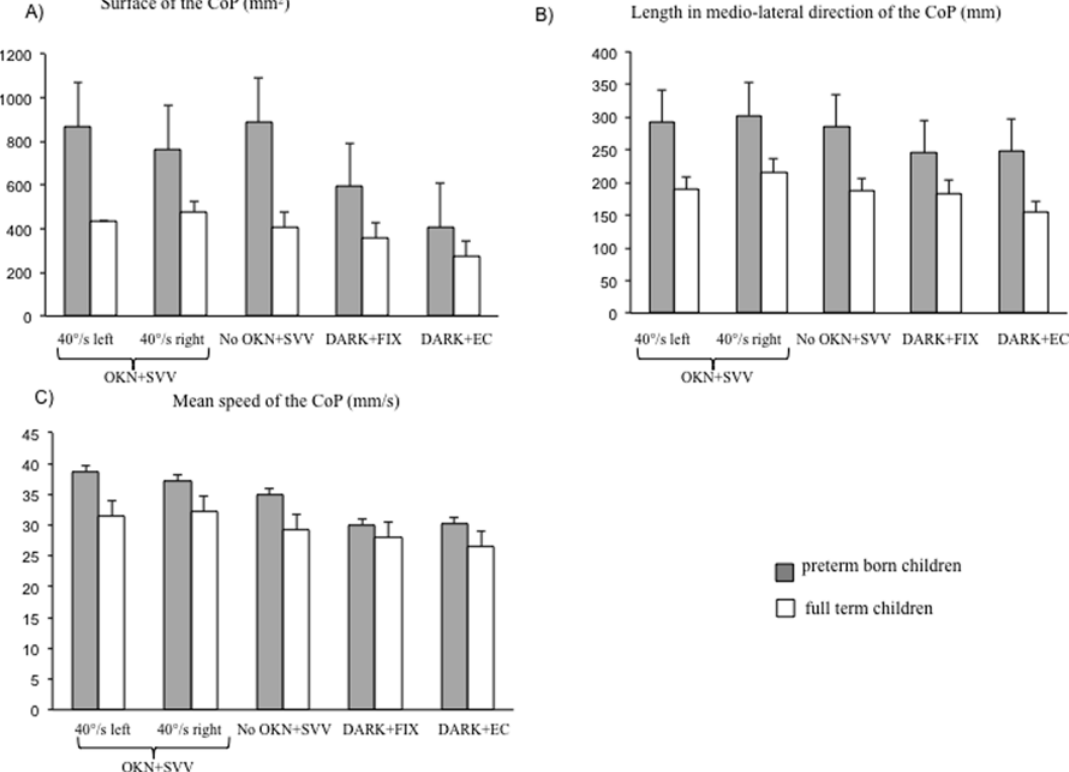
Fig 1. Postural parameters for the different conditions. Mean of Surface of the CoP (A), of length of CoP in the medio-lateral axis (B), and of mean speed of CoP (C) for the five different conditions (OKN+SVV: 40°/s left and 40°/s right, respectively, No OKN+SVV, DARK+FIX and DARK+EC) for the two groups of children tested. Verticals bars indicate the standard error. Asterisks indicate that the value is significantly different at the post-hoc test (p < 0.05).